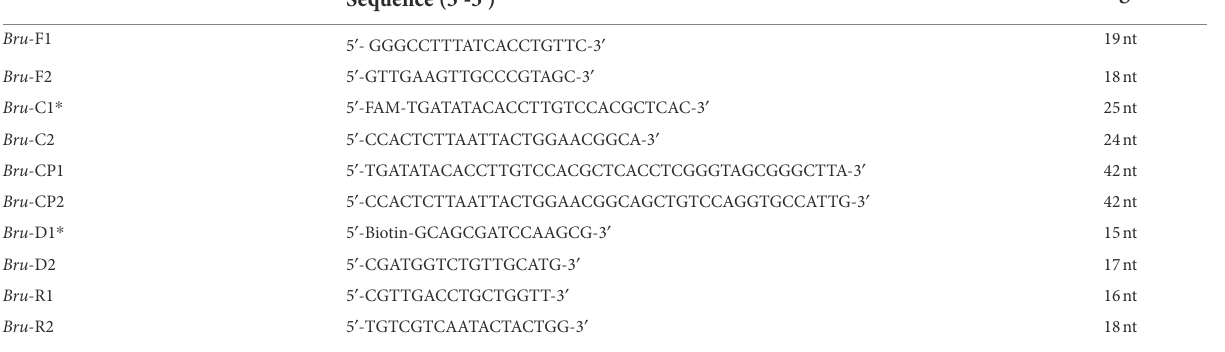
TABLE 1 The primers used in the B. abortus -LAMP-LFB